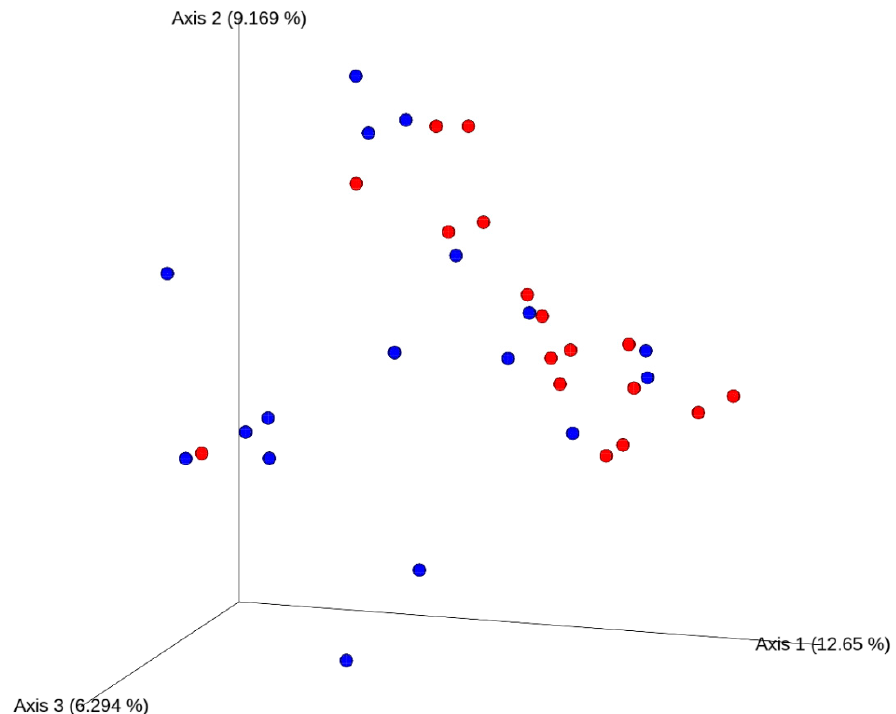
Figure 6. Principal coordinates analysis (PCoA) plot of the unweighted UniFrac distances from baseline stool samples of healthy male participants ( n = 34). High-trimethylamine- N -oxide (TMAO) producers in red ( n = 17; those with ≥ 40% urinary TMAO increase from 0 min study-baseline in response to choline bitartrate) and low-TMAO producers in blue ( n = 17; those with < 40% urinary TMAO increase from 0 min study-baseline in response to choline bitartrate) were significantly different from each other (Permutational multivariate analysis of variance, PERMANOVA p = 0.01, R 2 = 0.05 with 999 permutations using the Adonis function).